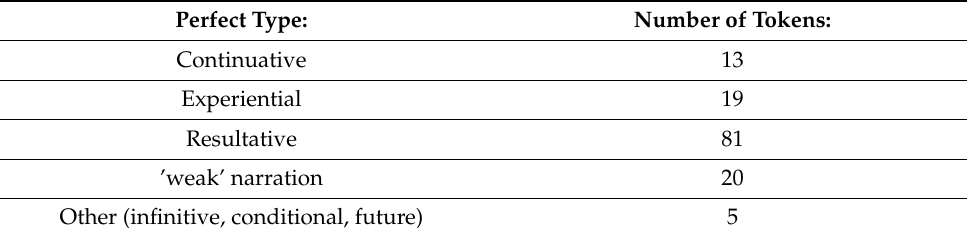
Table 2. Breakdown of perfects and PRS.PRF types in Breton, in corpus B.